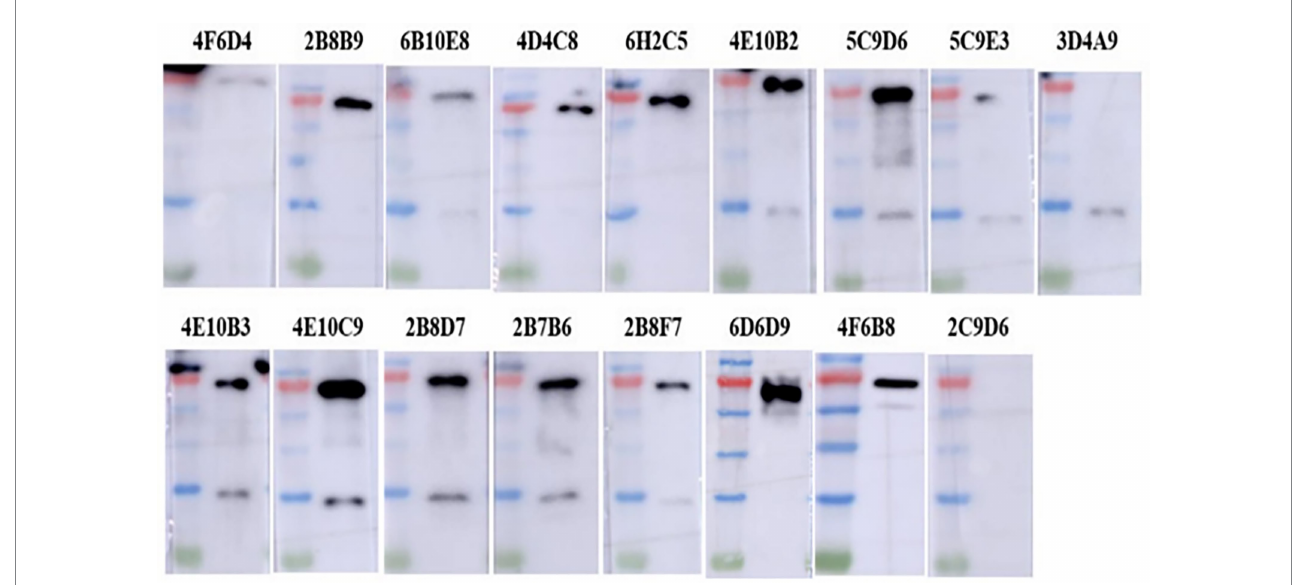
FIGURE 4 Reactivity of 17 mAbs against ASFV was preliminarily identified by WB. ASFV-infected PAMs were harvested at 72 h post-infection, electrophoresed on 12% SDS-PAGE gels and electro-transferred to polyvinylidene difluoride (PVDF) membranes, and detected with 17 mAbs as primary